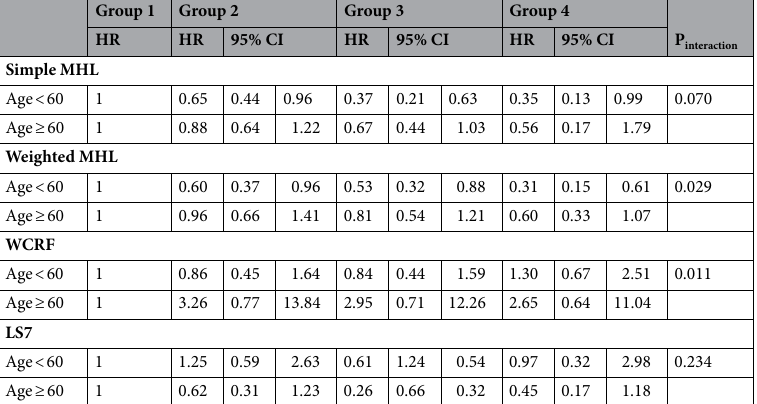
Table 3. Hazard ratios for cardiovascular disease among participants stratified by age < 60 years/o and ≥ 60 years/o, specified by simple Taiwan healthy lifestyle score, weighted Taiwan healthy lifestyle score, WCRF/ AICR recommended healthy lifestyle and Life’s Simple 7 according to the numbers of healthy lifestyle factors. Group 1 as those with lowest number of healthy lifestyle score, Group 2 and Group 4 as those with increasing the numbers of healthy lifestyle